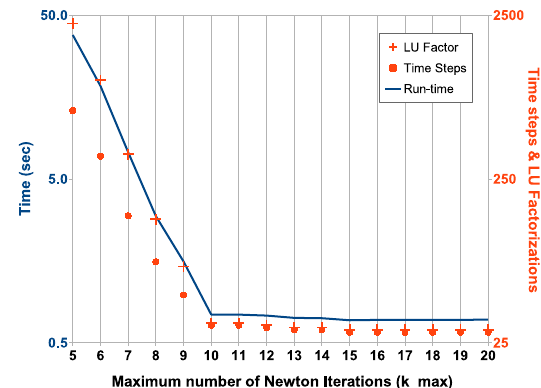
Fig. 3: Maximum Newton iteration metrics